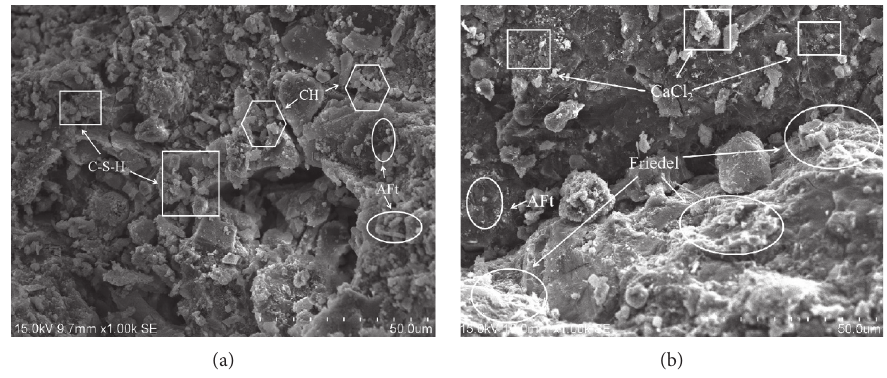
Figure 3: SEM image of rubber concrete: (a) hydration reaction and (b) erosion